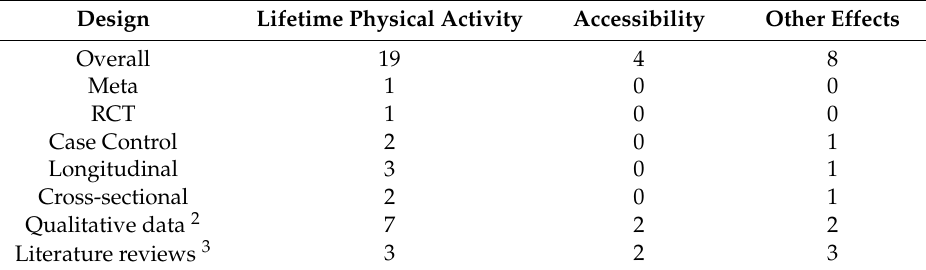
Table 9. Design of evidence within additional impacts 1